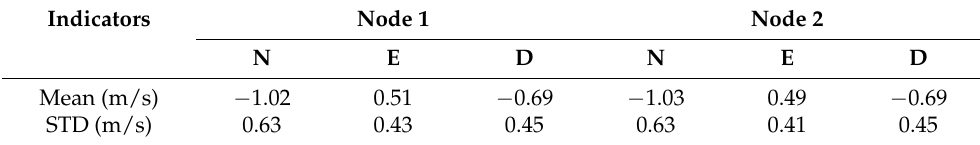
Table 5. Statistics of pure INS navigation position positioning velocity error.